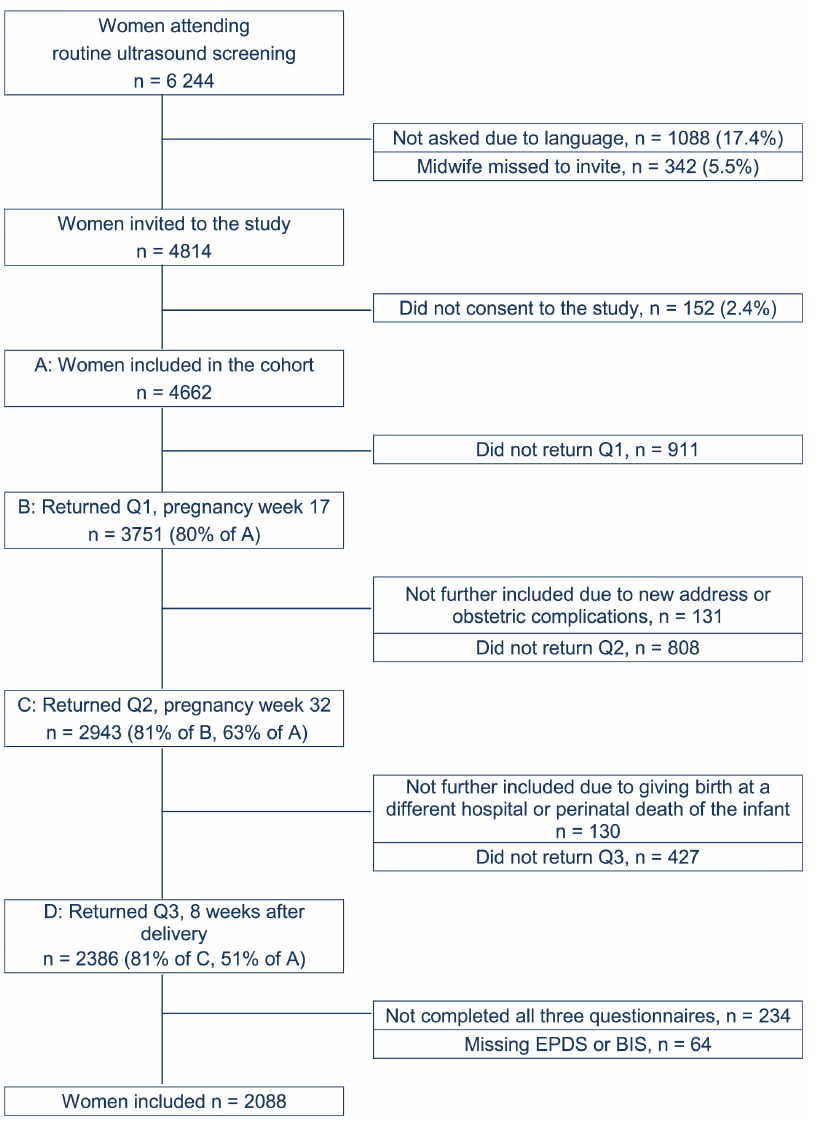
Figure 1. Study flow chart. Legend: EPDS – Edinburgh Postnatal Depression Scale. BIS – Bergen Insomnia Scale.